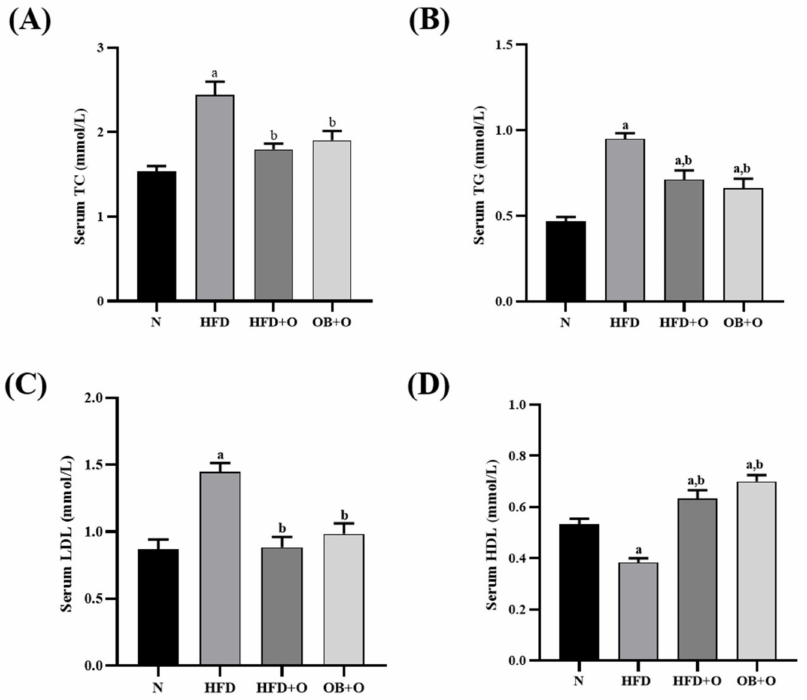
Figure 2. Serum lipid profiles in HFD-induced MAFLD rats. N, normal control; HFD, high-fat diet; HFD + O, high-fat diet+orlistat 10 mg/kg/day (protective model); OB + O, obese+orlistat 10 mg/kg/day (therapeutic model); TC, total cholesterol; TG, triglyceride; LDL, low-density lipopro- tein; HDL, high-density lipoprotein. ( A ) Serum TC; ( B ) Serum TG; ( C ) Serum LDL; ( D ) Serum HDL. Data are expressed as mean ± SEM, n = 6/group. One-way ANOVA, followed by Tukey post-hoc test. a p < 0.05 vs. N group, b p < 0.05 vs. HFD